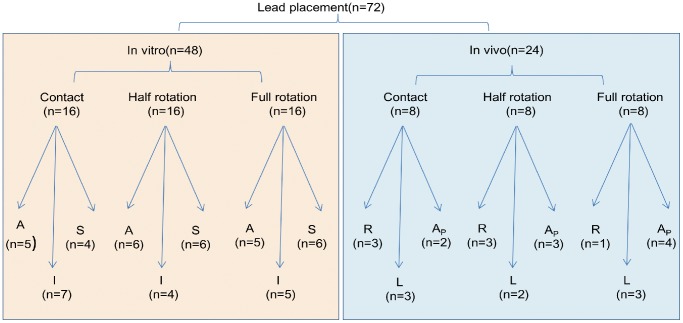
Illustration of the lead location in each group.A: anterior basal wall, I: inferior basal wall, S: septum, R: right ventricular anterior basal wall, L: left ventricular anterior basal wall, AP: apex.